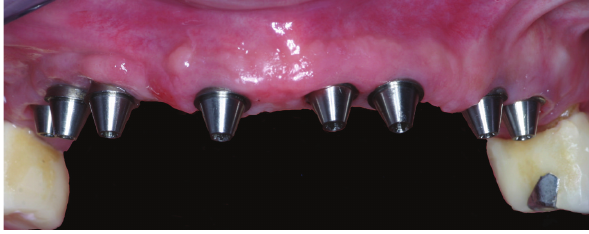
Figure 6: Clinical view. It is possible to appreciate the optimal soft tissue health.